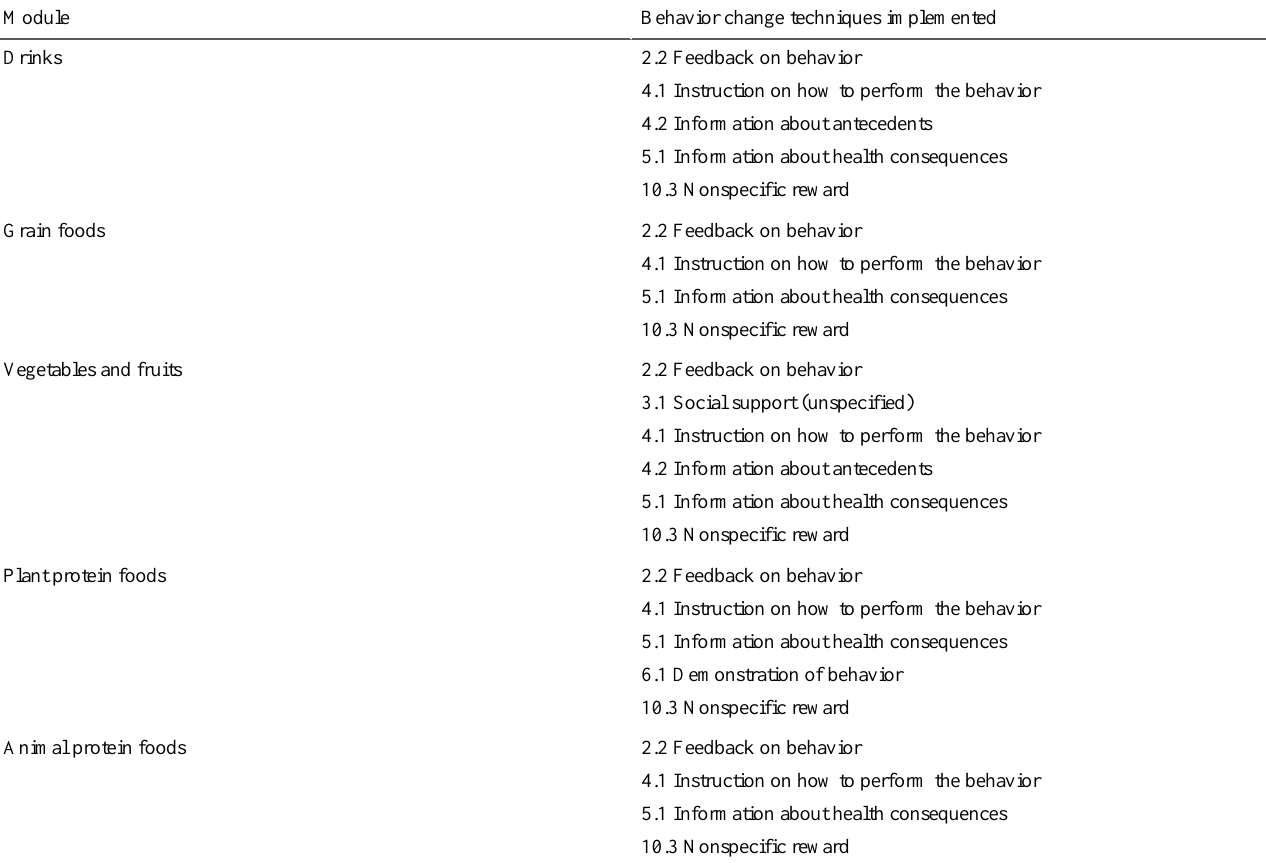
Table 2. Behavior change techniques implemented in Foodbot